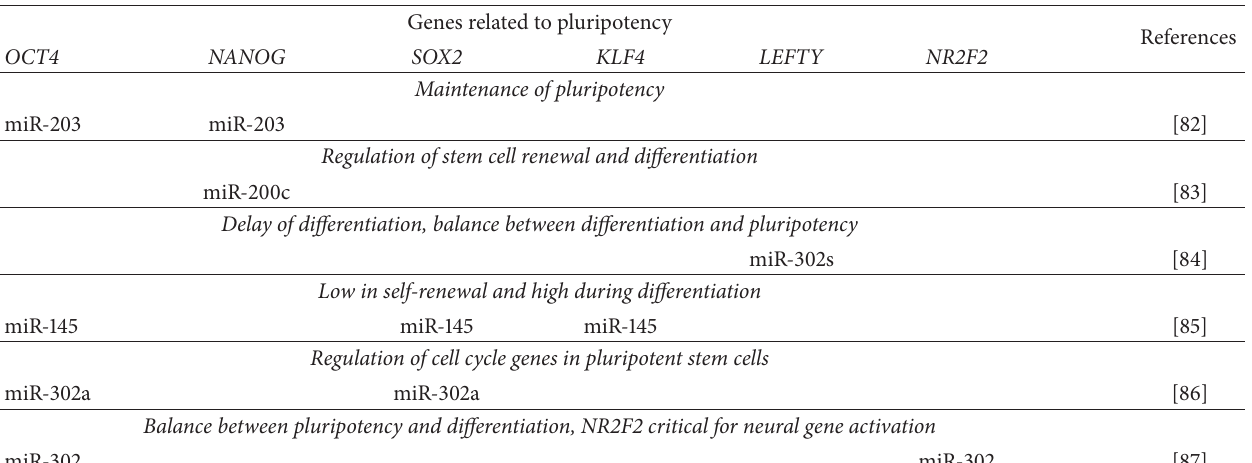
Table 1: MiRNAs regulating pluripotency and differentiation of